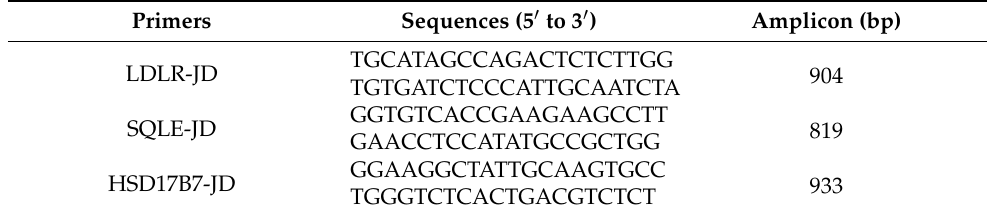
Table 1. The primers used in cell clones’